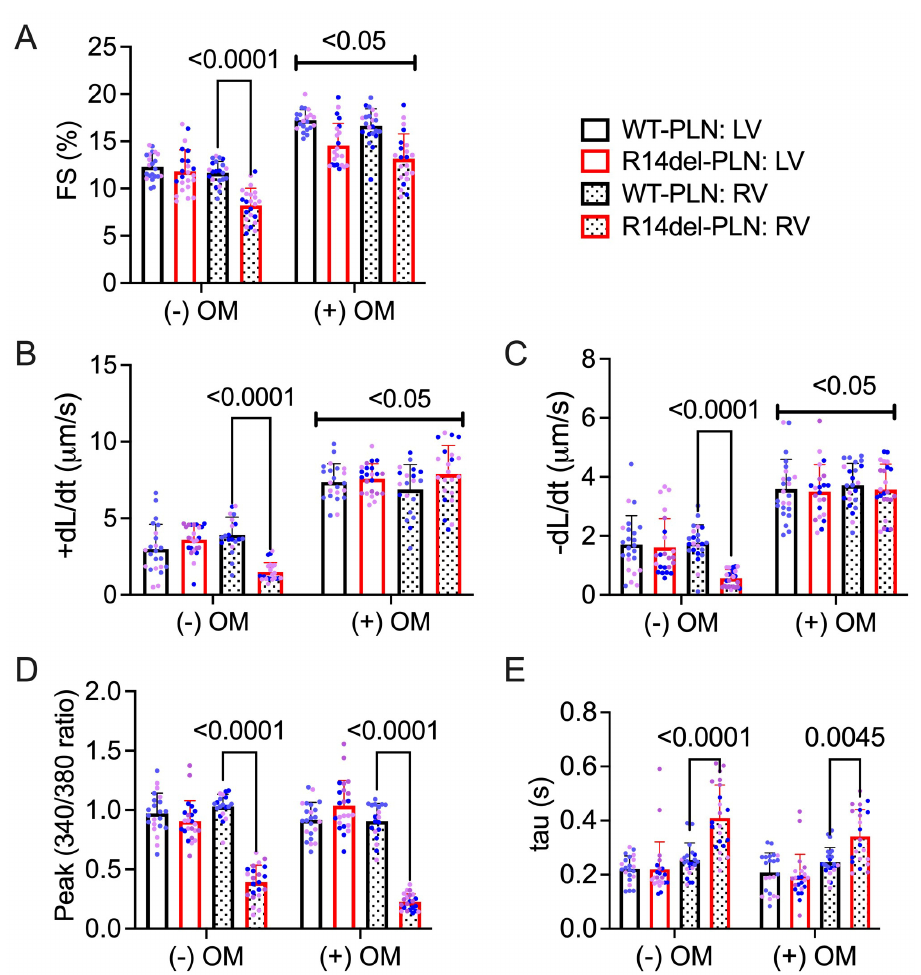
Figure 2. A positive cardiac inotropic drug, omecamtiv mecarbil (OM), improves contractility mechanics in R14del- PLN right ventricular skinned myocytes without affecting calcium handling. ( A ) Fractional shortening (FS) in the absence and presence of 100 nM myosin activator OM at 0.5 Hz. ( B ) Contraction velocity of sarcomere in the absence and presence of OM. ( C ) Relaxation velocity of sarcomere in the absence and presence of OM. ( D ) Ca 2+ transient amplitude is calculated with the Fura-2 ratio (340:380 nm) in the absence and presence of 100 nM OM at 0.5 Hz with 1.8 mM Ca. ( E ) Relaxation time constant (tau) of calcium transient in the absence and presence of OM is presented. N = 3 hearts (20–22 cells)/group. Blue and pink dots represent male and female data points, respectively. Data are expressed as mean ± SD, and statistical analyses were performed in all groups using ordinary two-way ANOVA followed by Tukey’s multiple comparison